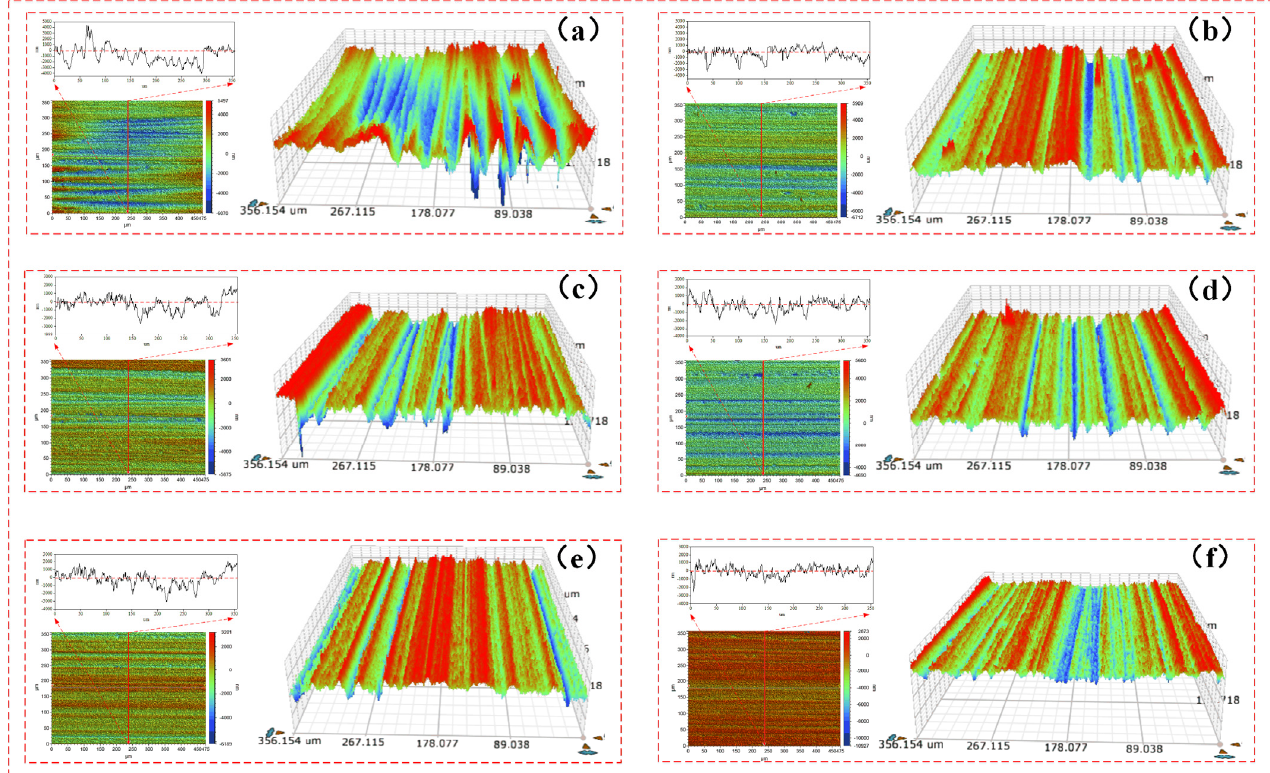
Figure 11. The three-dimensional morphology of quartz glass workpiece lapping by FAP samples at different processing stages. Note: ( a ) The FAP samples (0 – 30 min) lapping quartz glass